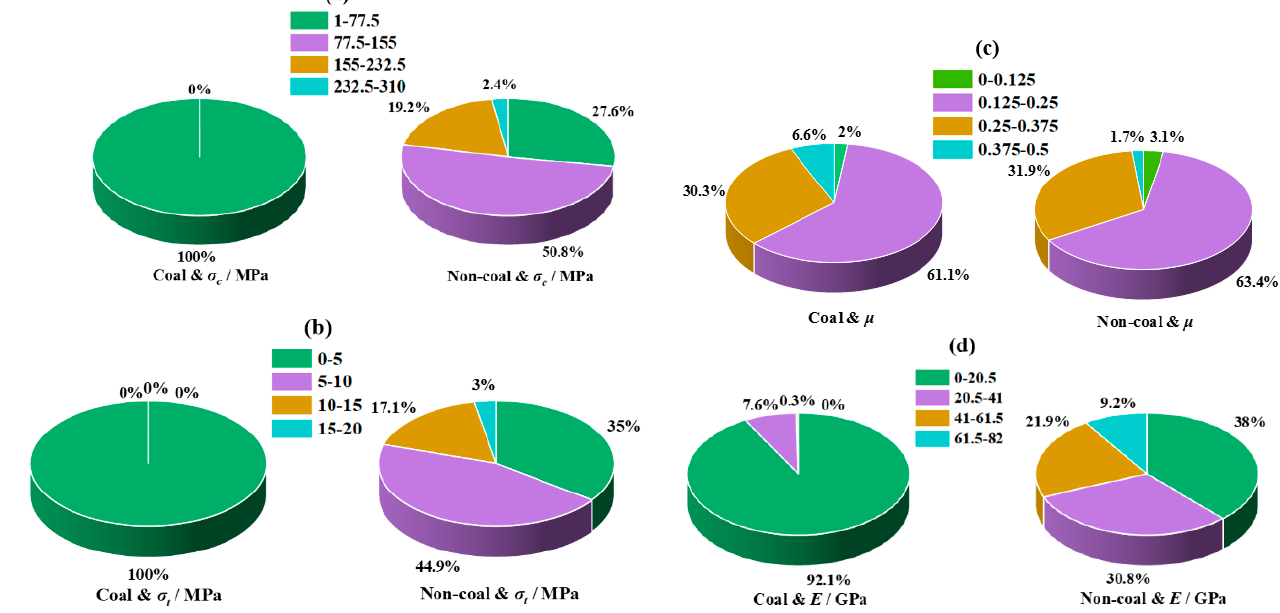
Figure 4. Proportion statistics of basic mechanical parameters: ( a ) uniaxial compressive strength σ c , ( b ) uniaxial tensile strength σ t , ( c ) Poisson’s ratio µ and ( d ) elastic modulus